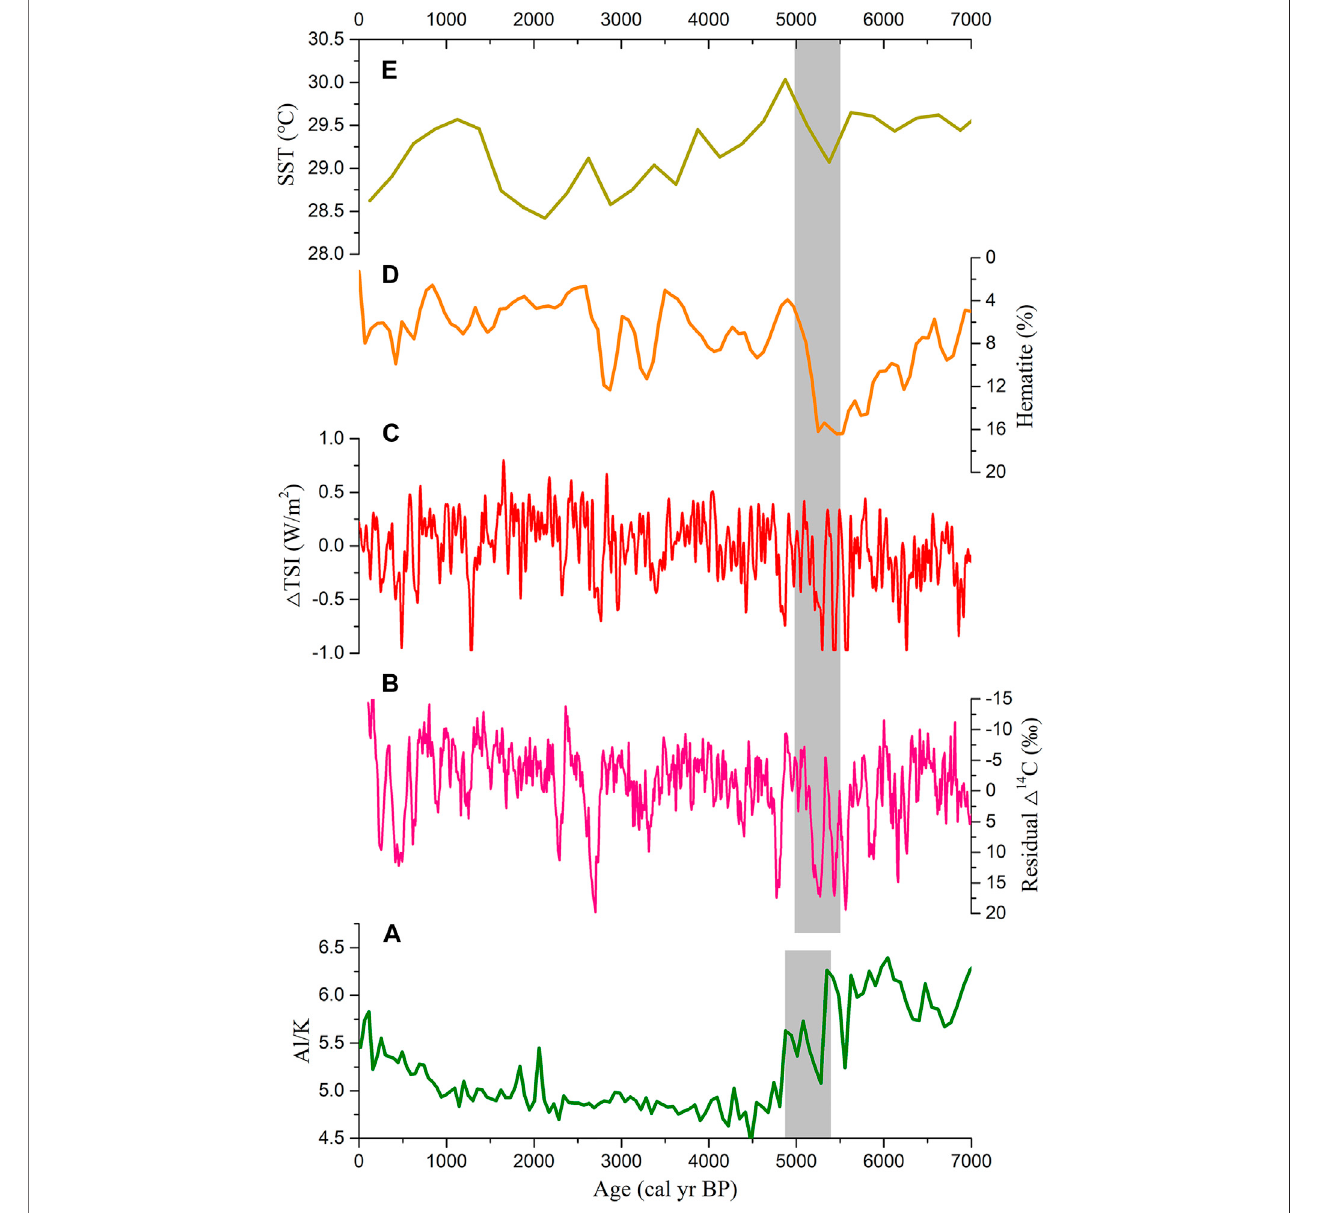
FIGURE 5 | Comparison between various paleoclimate records: (A) Al/K ratios from core GH6; (B) atmospheric residual Δ 14 C record (Stuiver et al., 1998); (C) reconstructedtotalsolarirradiance(TSI)fromice-core 10 Bedata(Steinhilberetal.,2009); (D) hematite-stainedgrainsfromthesubpolarNorthAtlantic(Bondetal.,2001); and (E) sea surface temperature (SST) in the Western Paci fi c Warm Pool (Stott et al., 2004). The grey bar indicates the abrupt climate change recorded in core GH6.